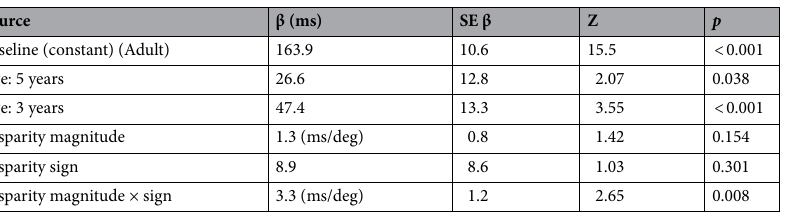
Table 1. Latency to the vergence response (T L ) was fit with a linear mixed model including age (categorical), disparity magnitude (continuous), disparity sign, and a magnitude by sign interaction as fixed variables and participant as a random variable. Disparity sign is coded such that a positive beta indicates a longer latency (slower response) for stimuli presented at positive (far) disparities than those presented at negative (near)